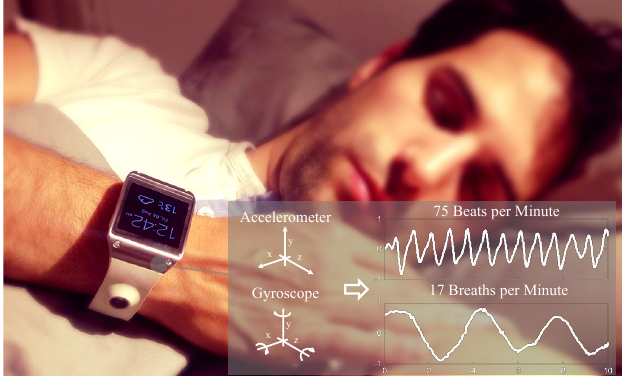
Fig. 1. We present a novel approach for measuring cardiac and respiratory parameters from wrist motions using a smart watch (Samsung Galaxy Gear), even when the wrist is not held against the